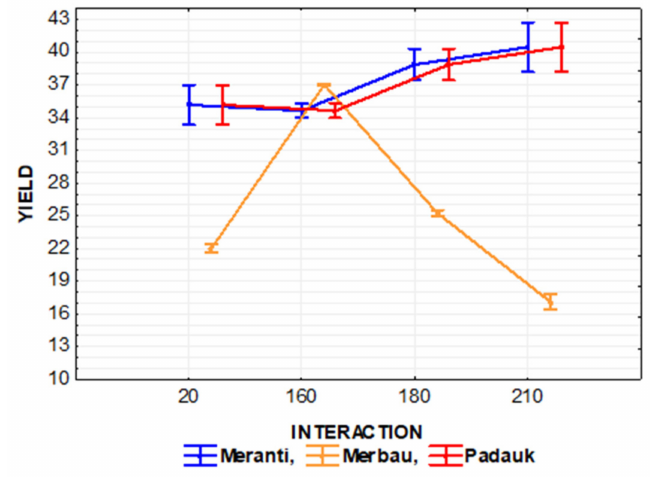
Figure 12. The effect of thermal modification temperature and wood species on YIELD